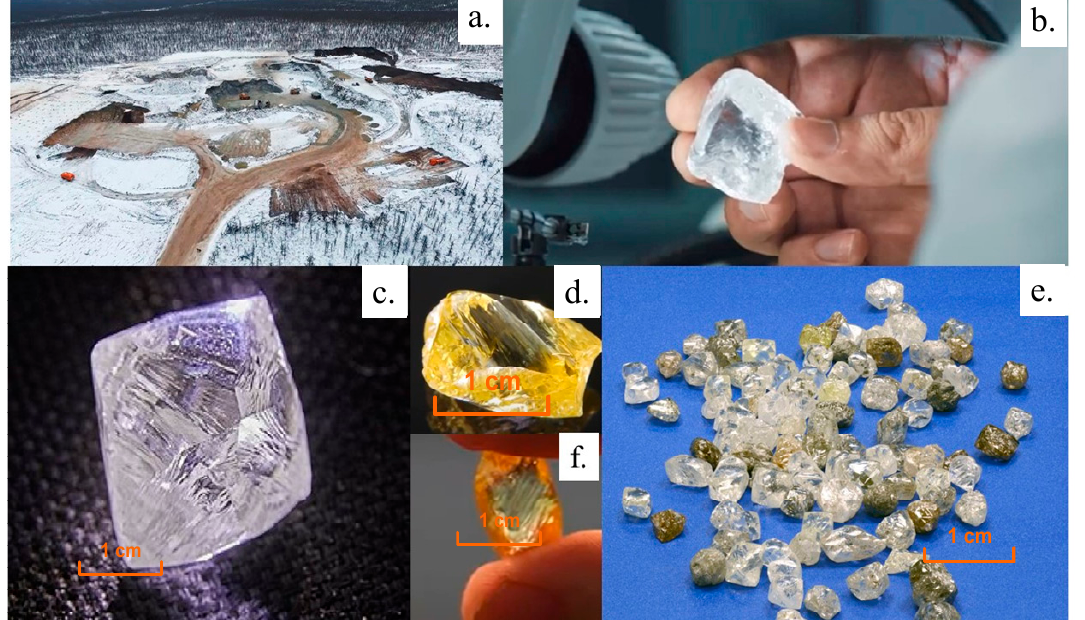
Figure 3. ( a ). Photo of the open pit in the Zapolyarnaya pipe Upper Muna field. ( b ). Large gem quality diamond from Zapolyarnaya pipe. ( c – f )-diamonds from Zapolyarnaya pipe.